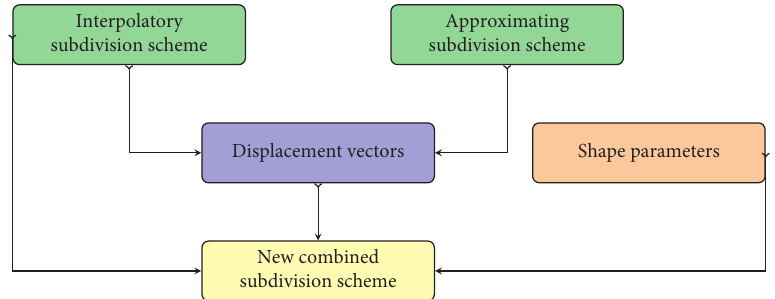
Figure 1: Flowchart for the construction of combined subdivision